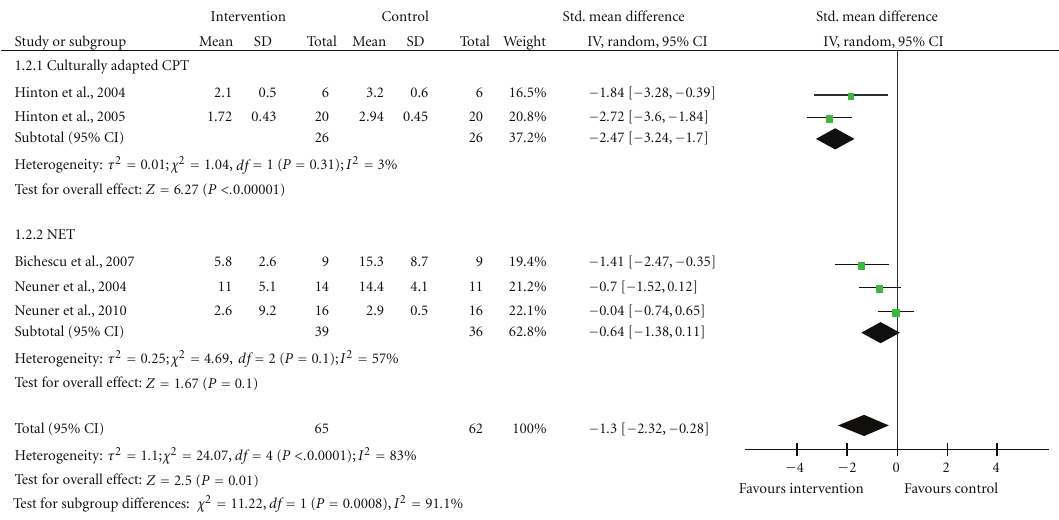
Figure 3: Forest plot of subgroup analysis culturallyadapted CPT versus NET versus CPT; Outcome: Depression